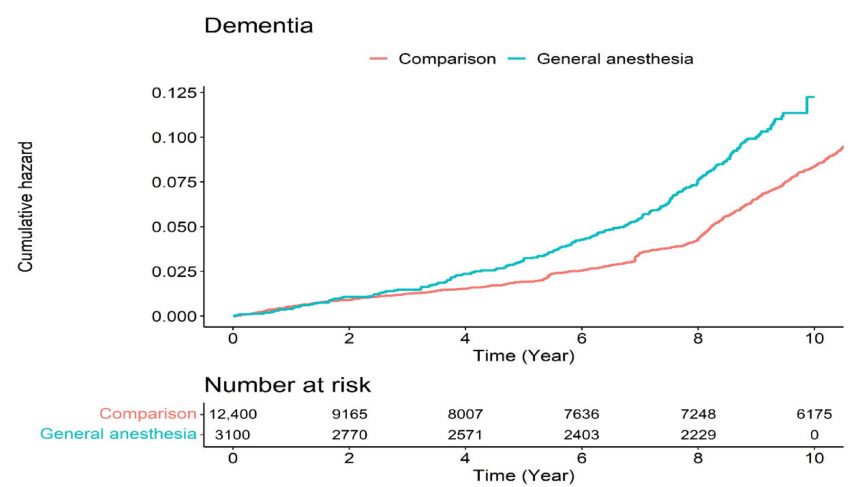
Figure 3. Cumulative hazard plot of dementia between the comparison group and those who underwent general